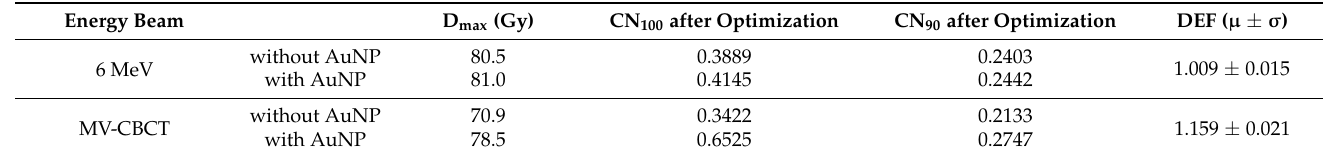
Table 1. Data summary of evaluation parameters for each simulation. Energy